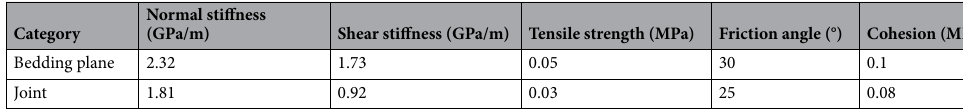
Table 3. Discontinuities mechanical parameters.